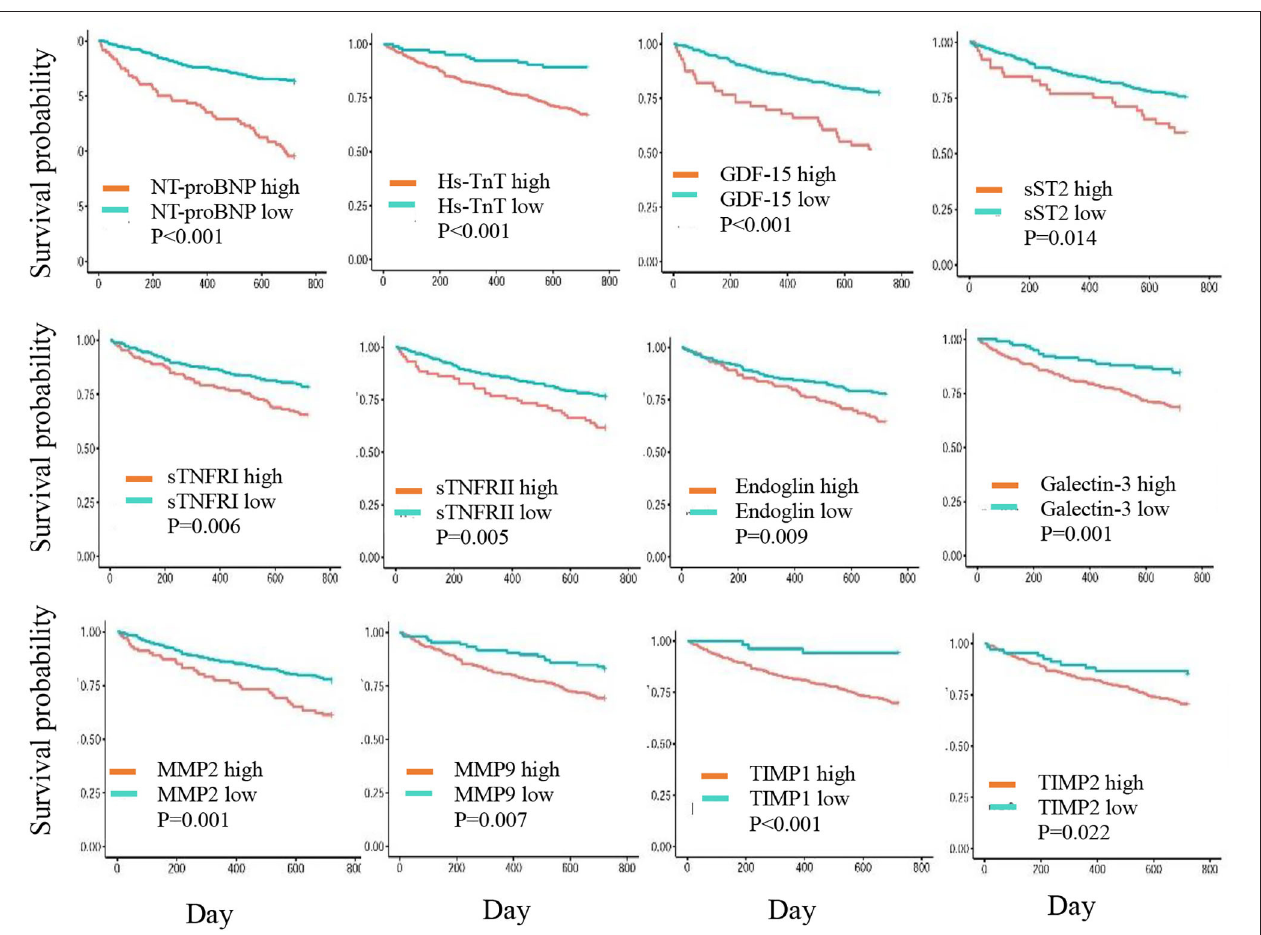
FIGURE 1 | Kaplan-Meier curves showing 2-year cumulative survival trends in patients with biomarker levels in high- and low-risk